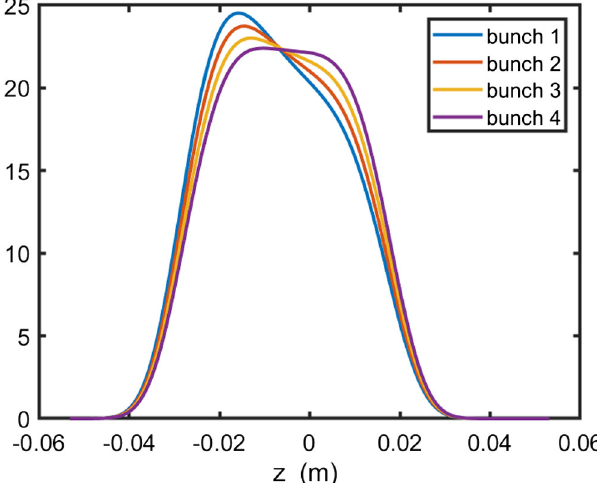
FIG. 11. The four guard bunches at the end of a train of 26, each with ξ ¼ 1 . 5 . These lean forward.